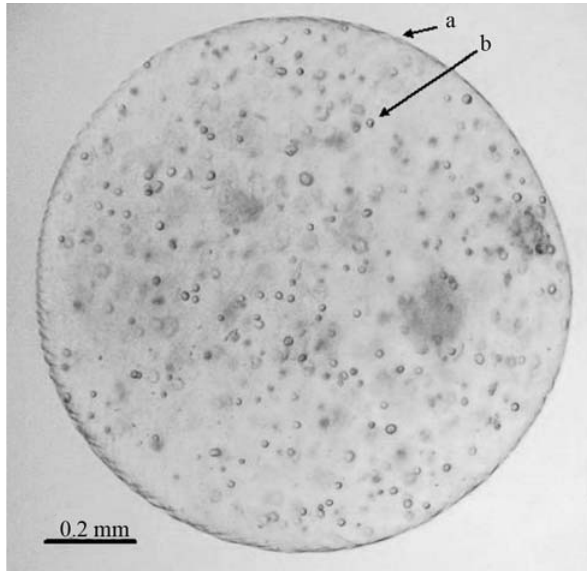
Figure 3 - Microcapsule containing baby hamster kidney (BHK) cells maintained in vitro for 4 weeks. a) alginate gel; b) BHK cells.